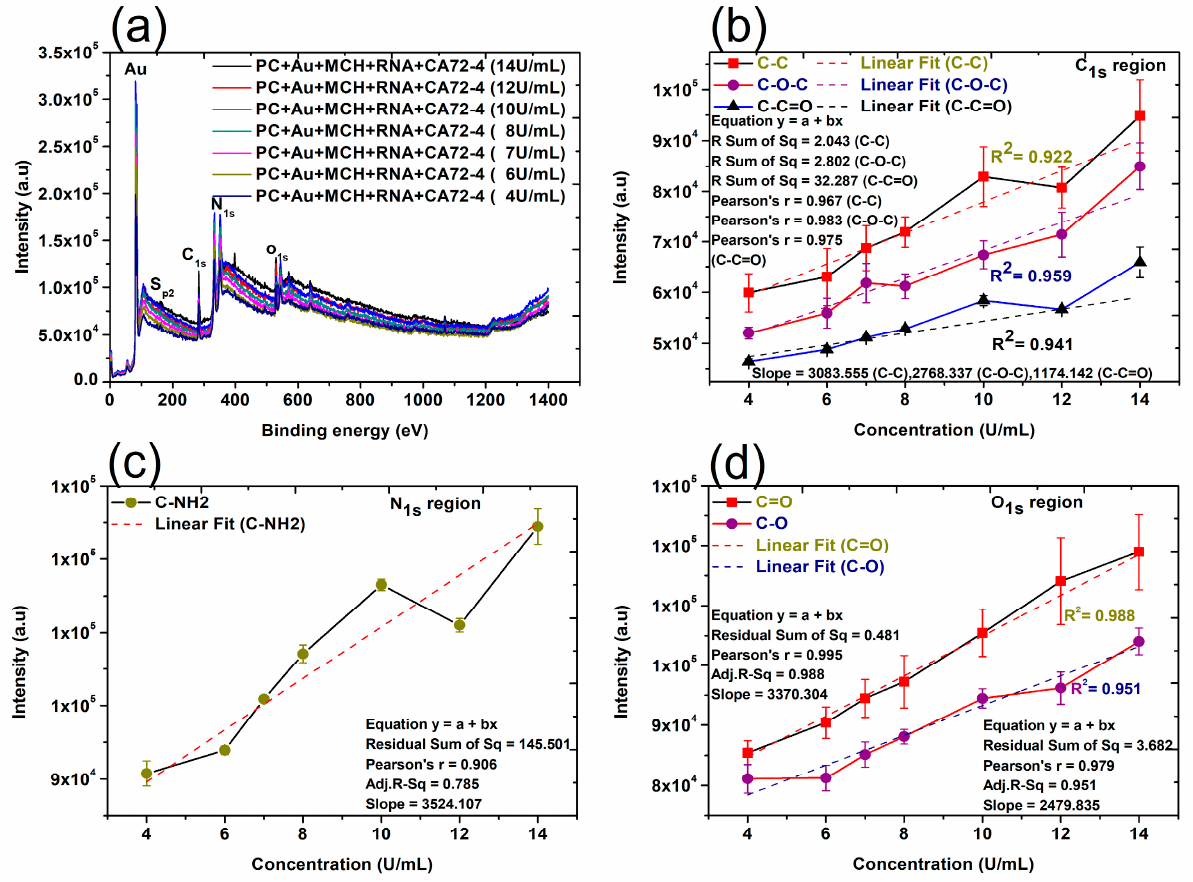
Figure 6. X-ray photoelectron spectroscopy (XPS) spectra and linear relation of adsorption of different concentrations of cancer antigen CA 72-4 on our electrochemical sensor. ( a ) The XPS spectra of adsorption of different concentrations of cancer antigen CA 72-4 on our electrochemical sensor. Plots of the concentrations of CA72-4 and the intensity of ( b ) the C-C, C-O-C, and C-C=O bonding C 1s region, ( c ) the C-NH 2 bonding N 1s region, and ( d ) the C=O, C-O bonding O 1s region.